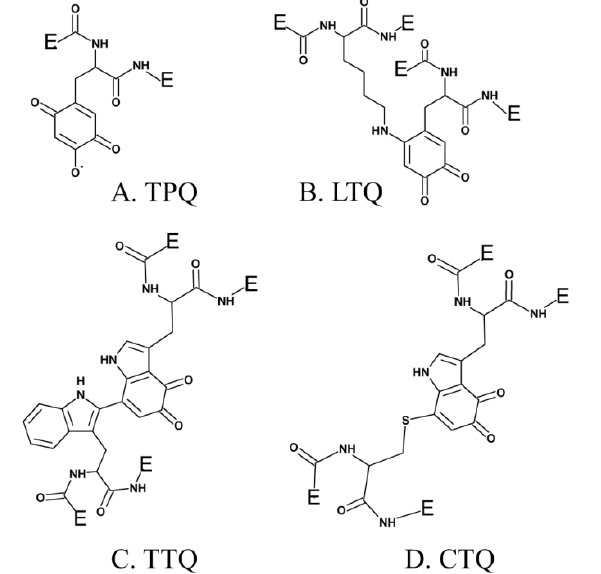
Figure 1. Quinone-containing cofactors formed by the post-translational modification of tyrosine or tryptophan side